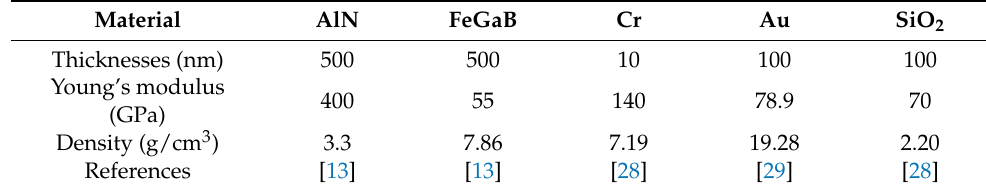
Figure 3. Machining process flow for the developed MEMS magnetoelectric antenna. Table 1. List of used materials thicknesses and Young’s moduli .